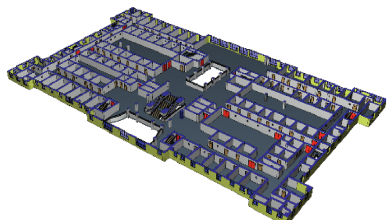
Figure 18: Fire model diagram of floor 3.